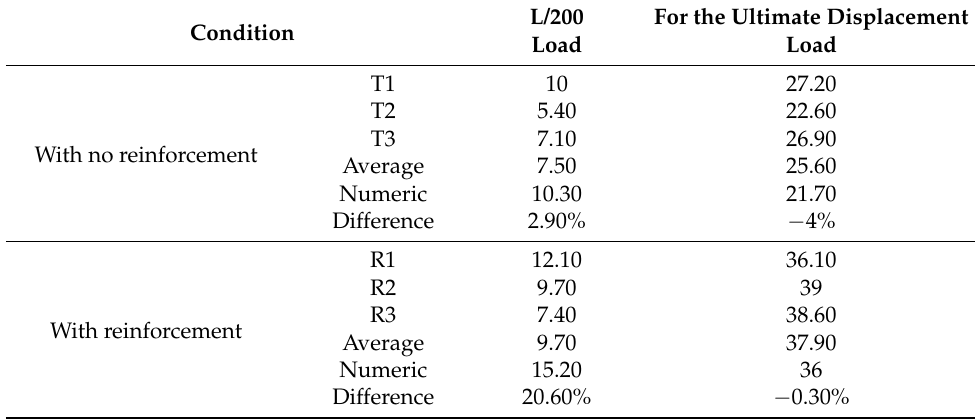
Figure 4. Load curve × displacement for reinforced beam. Table 6. Comparison between experimental and numerical values for the force at the service and ultimate limit.